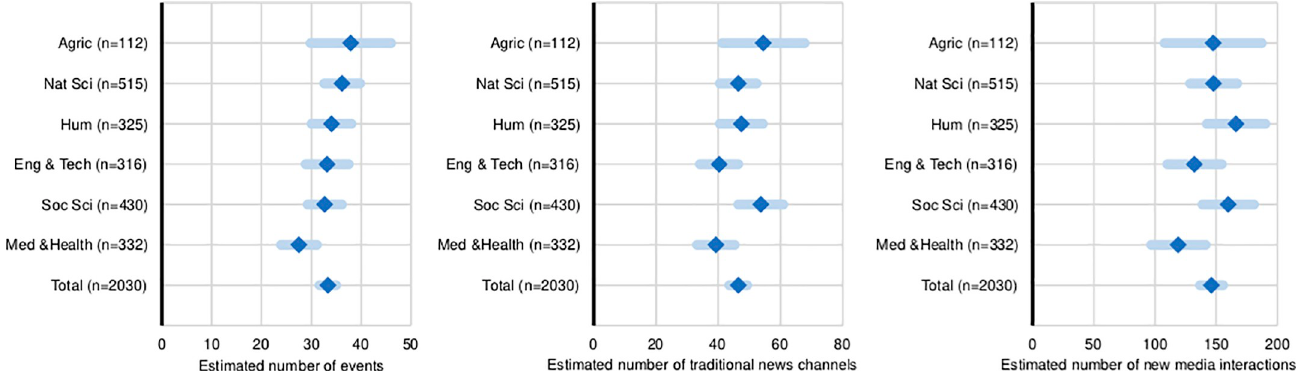
Fig 2. Frequency of public communication activity compared across sciences. Estimated average number of public events, traditional media, and social media channels by research institutes, in the twelve months prior to the study. ( N = 2,030).